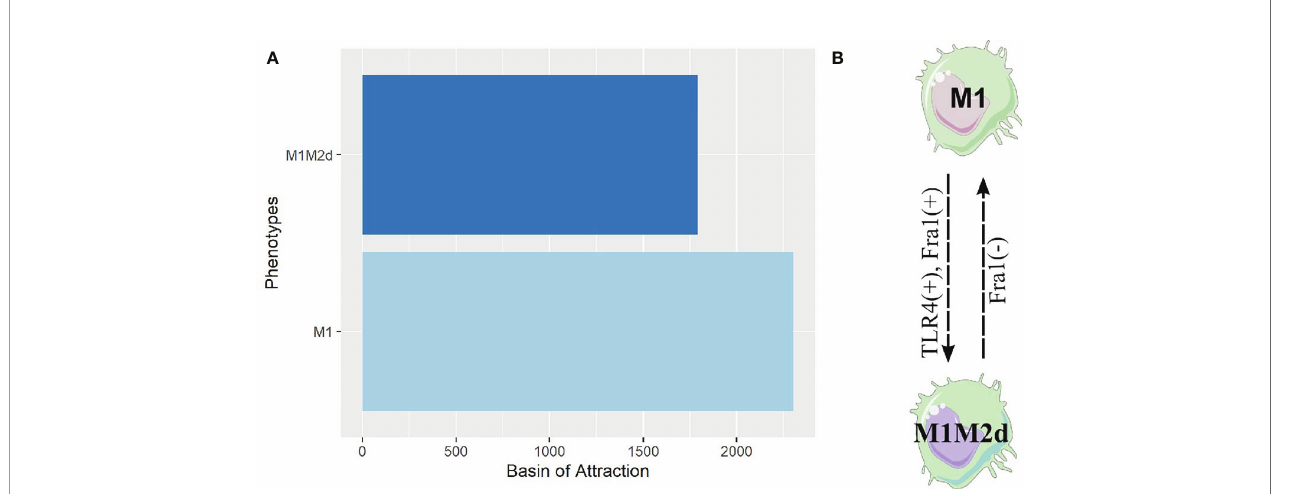
FIGURE 6 | Attractors and cell fate map of our TGEM. (A) Bar plot of the attractors obtained from our theoretical genetically modi fi ed macrophage. For this analysis we set the value of NF k B to 1 and HIF1- a to 0, and simulated until we obtained these attractors. (B) Cell fate map of our theoretical genetically modi fi ed macrophage. By analyzing the plasticity of phenotypes through single gene perturbation of the genetically modi fi ed macrophage, we obtained the rules of genetic perturbation that contribute transition between macrophages phenotypes. Here (-) means the node was turned off and (+) means the node was turned